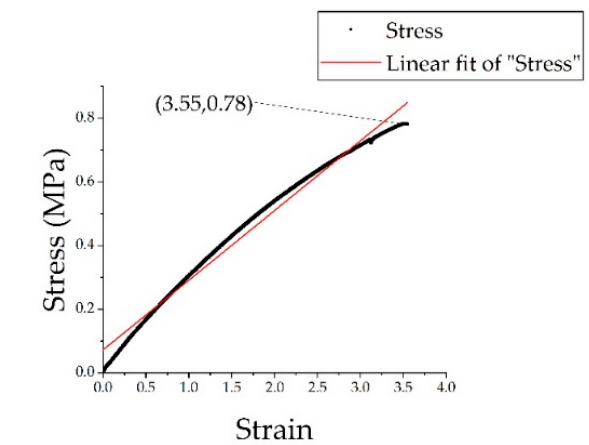
Figure 3. The tensile stress–strain curve of novel dry